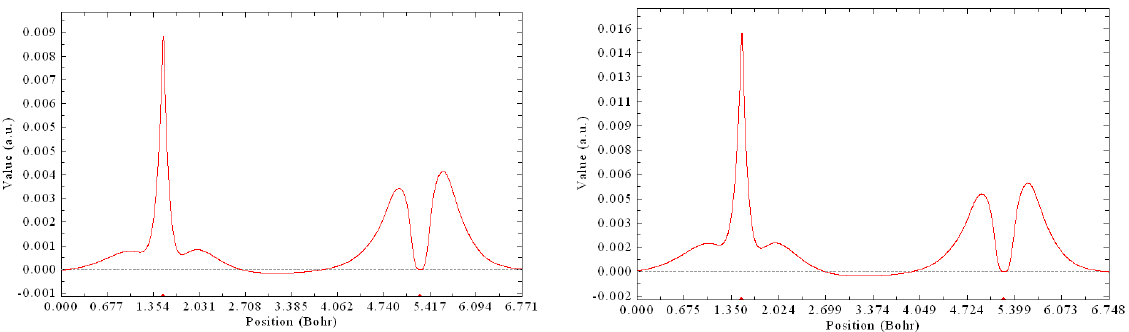
Figure 14. Curve showing various properties on the line (Cu--N) of the two complexes (left complex, right complex).